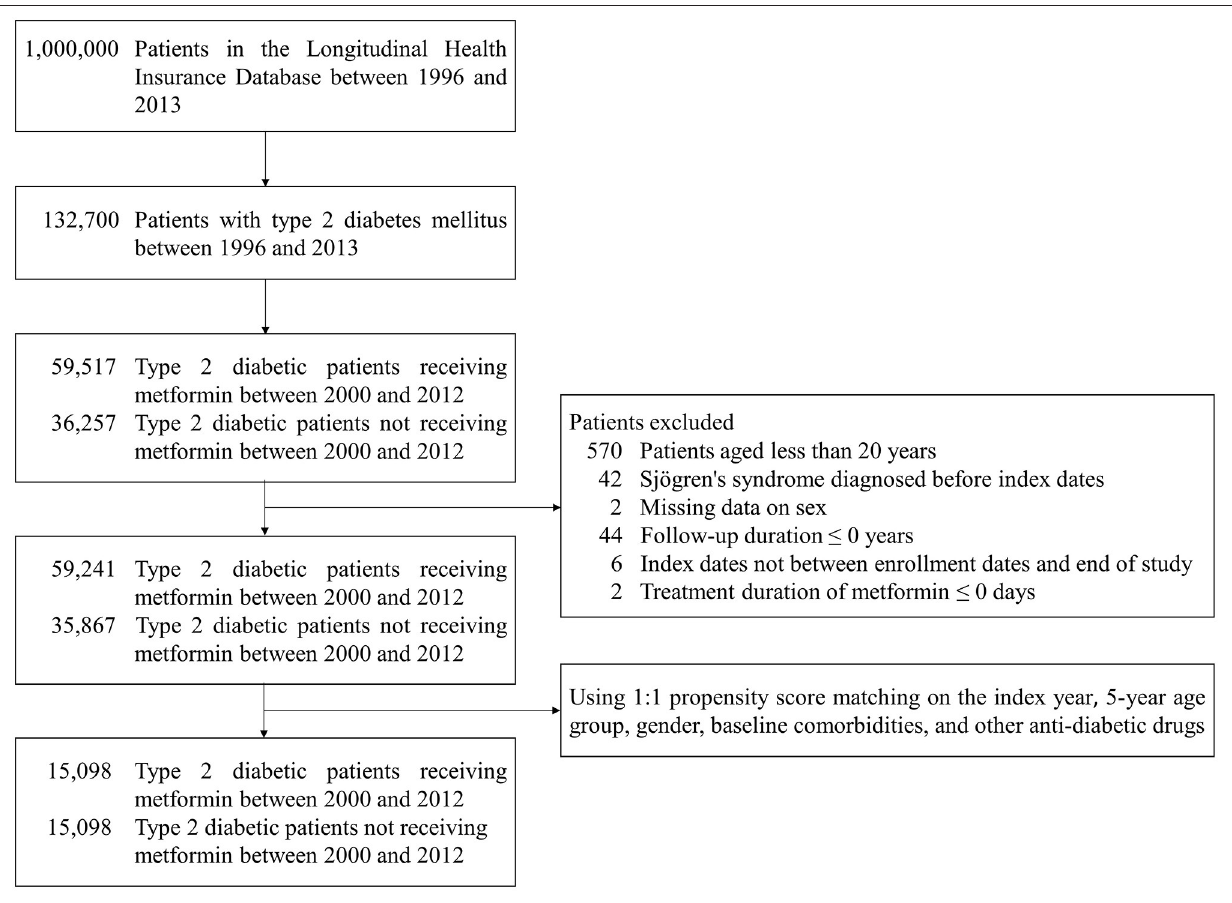
hazards models; adjusted hazard ratios (aHRs) with 95% CIs were estimated by multivariate Cox proportional hazards models with the covariates of age, gender, comorbidities, and medications. Significant levels of 0.05 were used. To test the proportional assumption for the multivariate Cox regression model, a Wald chi-squared test was performed.